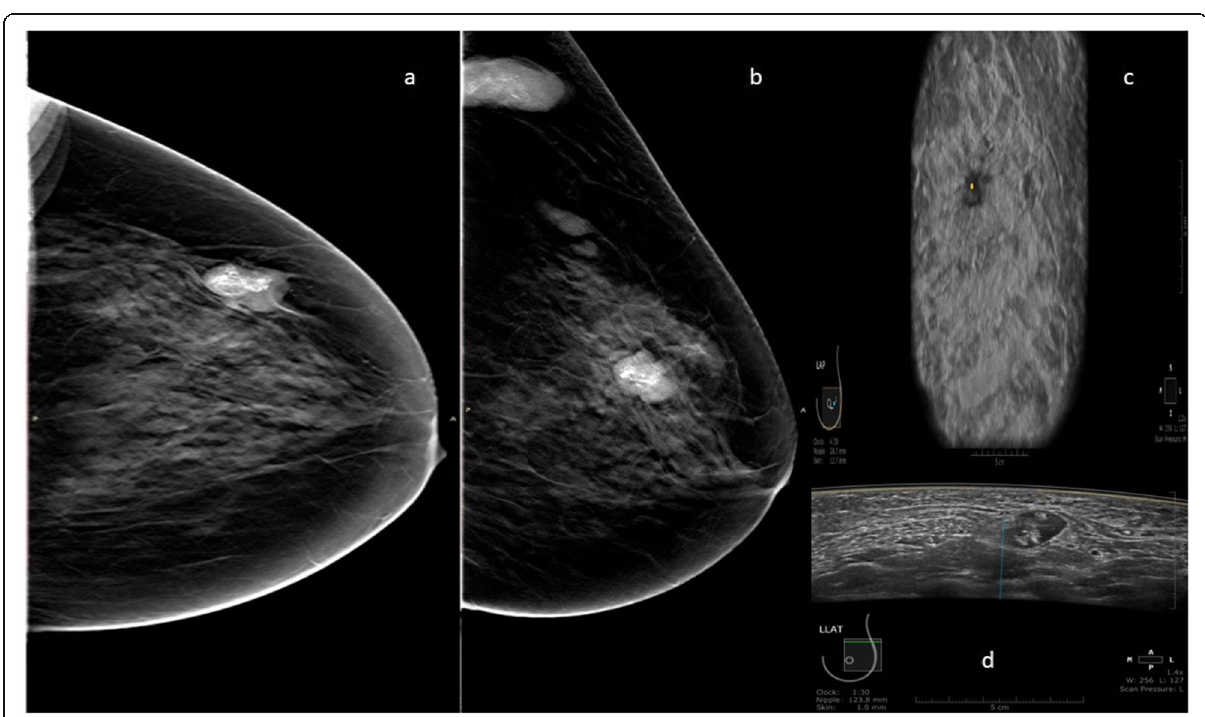
Fig. 3 A 74-year-old female patient was presented to us by a clinically palpable left breast lump. Digital mammography tomosynthesis CC and MLO views ( a , b ) of the left breast show an oval-shaped circumscribed high-density UOQ mass with no associated skin thickening (BIRADS IV). Automated ultrasound left AP coronal image ( c ) show small irregular defect at distance 28.3 mm from the nipple. Automated ultrasound image ( d ) shows a right irregular shaped mass with spiculated margins, non- parallel orientation, and heterogeneous echo pattern. (BIRADS V). A core biopsy was done and revealed adenocarcinoma. Automated ultrasound was superior to tomosynthesis in the characterization of the lesion while tomosynthesis was superior in the detection of axillary